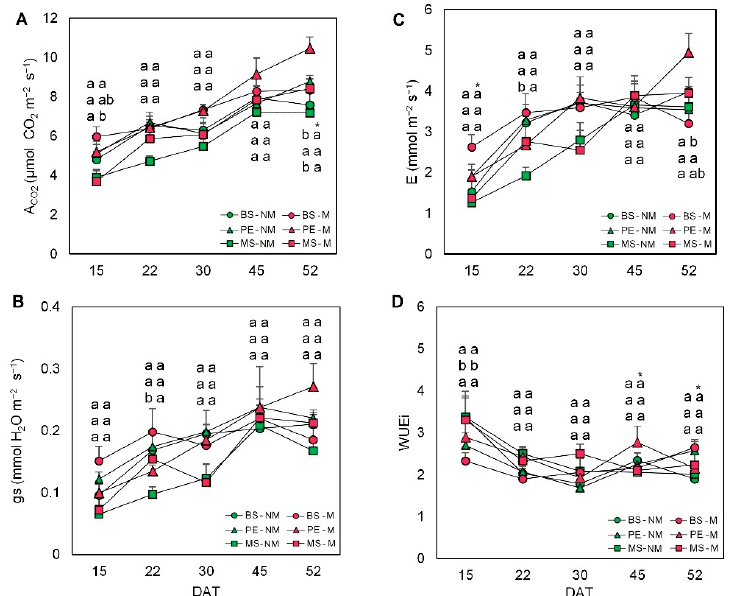
Figure 3. ( A ) Evolution of photosynthetic rate (A CO ), ( B ) stomatal conductance (gs), ( C ) transpiration 2 rate (E), and ( D ) intrinsic water use efficiency (WUEi) in escarole plants of the commercial variety “Bekele” cultivated under non-mycorrhizal (NM) and mycorrhizal (M) conditions and covered or not with mulching treatments. Bars show the means of five plants ± standard error. Different letters show significant differences among mulching treatments while the asterisk (*) indicates significant differences due to AMF inoculation within each mulching treatment according to Tukey’s and t -tests ( p ≤ 0.05). Abbreviations used: days after transplant (DAT), bare soil (BS), polyethylene mulch (PE), and mushroom substrate-based hydromulch